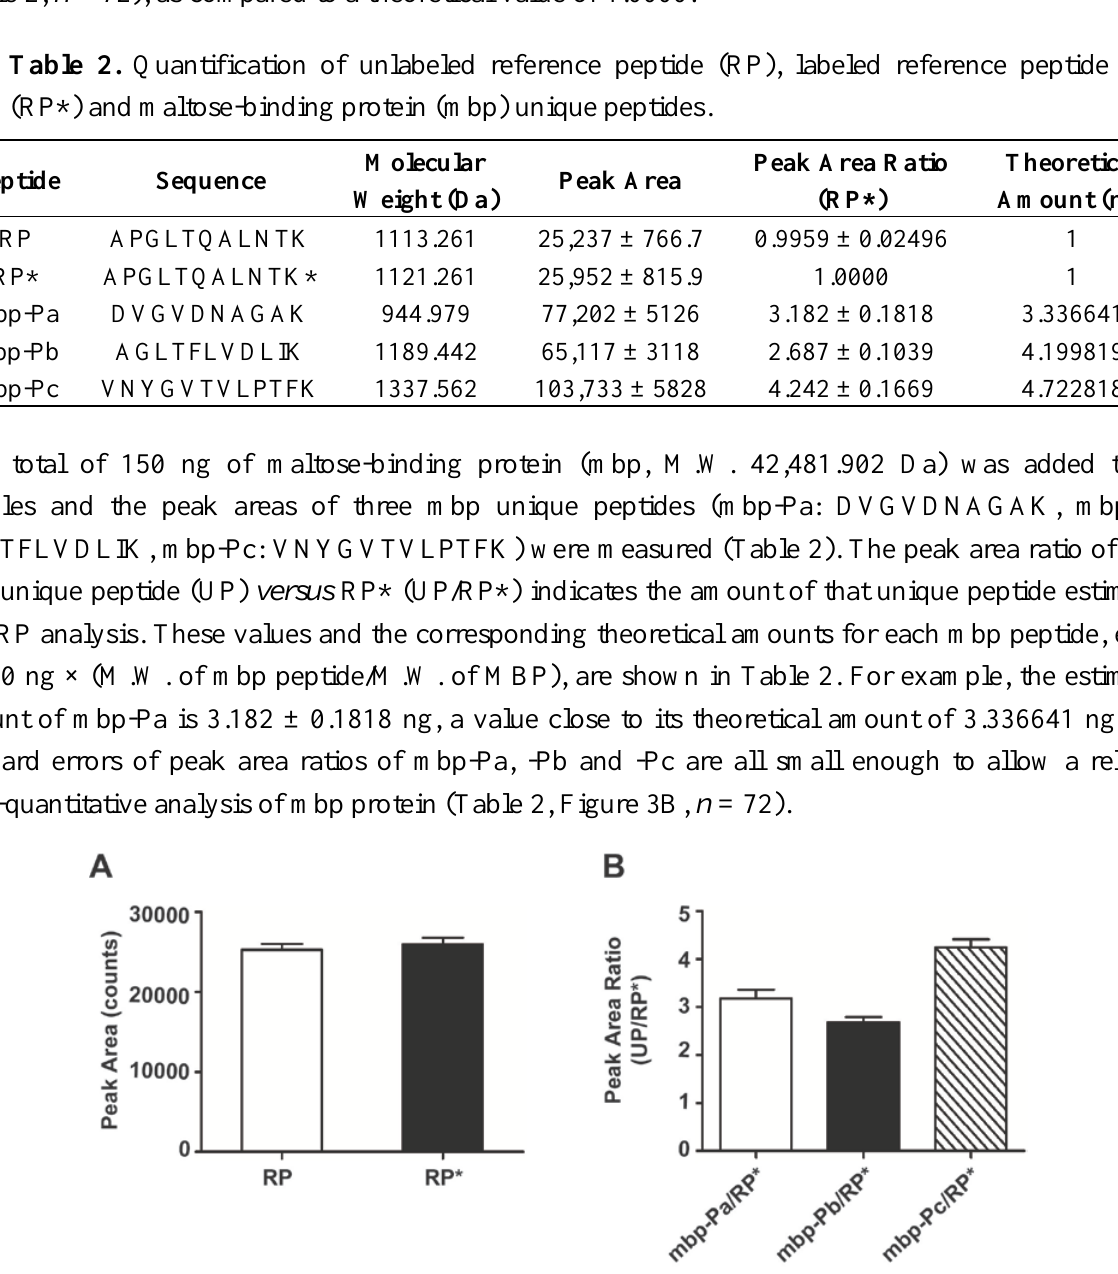
Figure 3. Semi-quantitative analysis of LCM-procured samples by triple-quadrupole mass spectrometry. ( A ) One ng of 13 C and 15 N labeled reference peptide